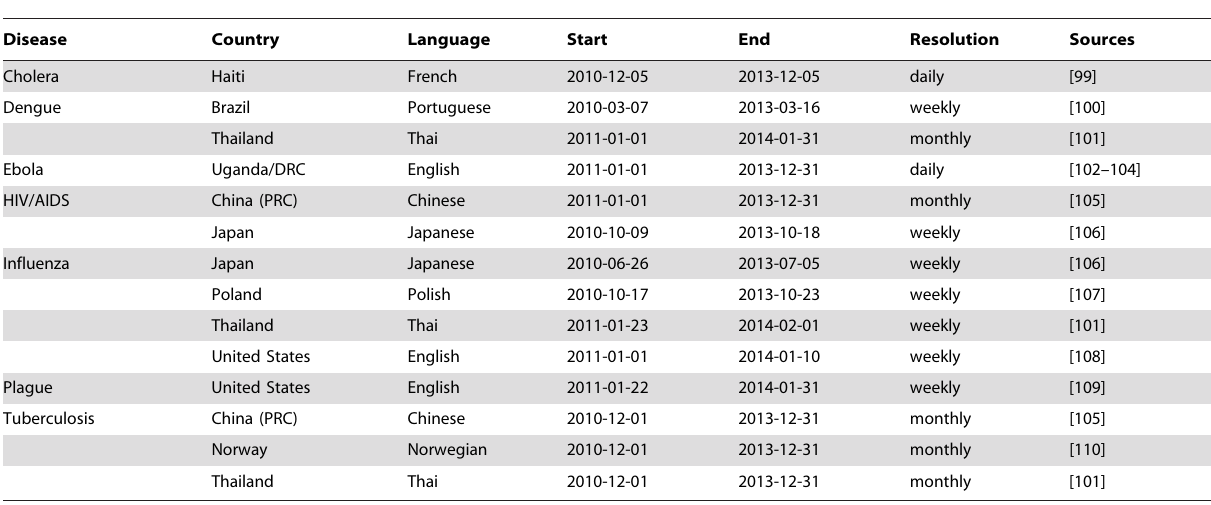
Table 1. Diseases-location contexts analyzed, with data